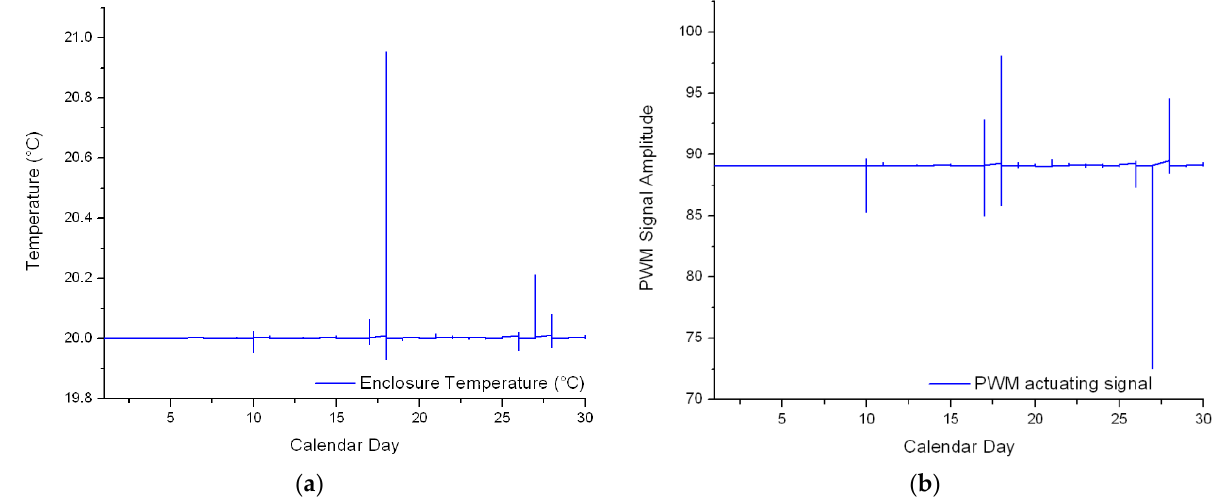
Figure 16. ( a )Temperature inside the enclosure and ( b ) actuating signal of the controller. Figure 16. ( a ) Temperature inside the enclosure and ( b ) actuating signal of the controller.